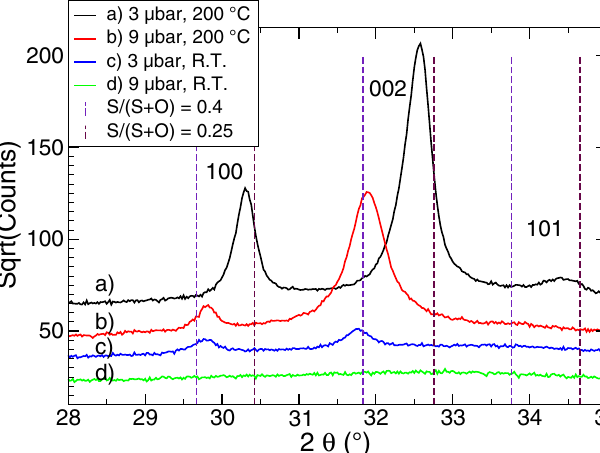
Fig. 3. XRD patterns of Zn(O,S) thin films on glass/Mo sub- strates prepared with and without substrate heating at two different Ar pressures. Vertical lines indicate calculated peak positions assuming hexagonal symmetry and a linear shift in lattice constants between ZnO and ZnS.